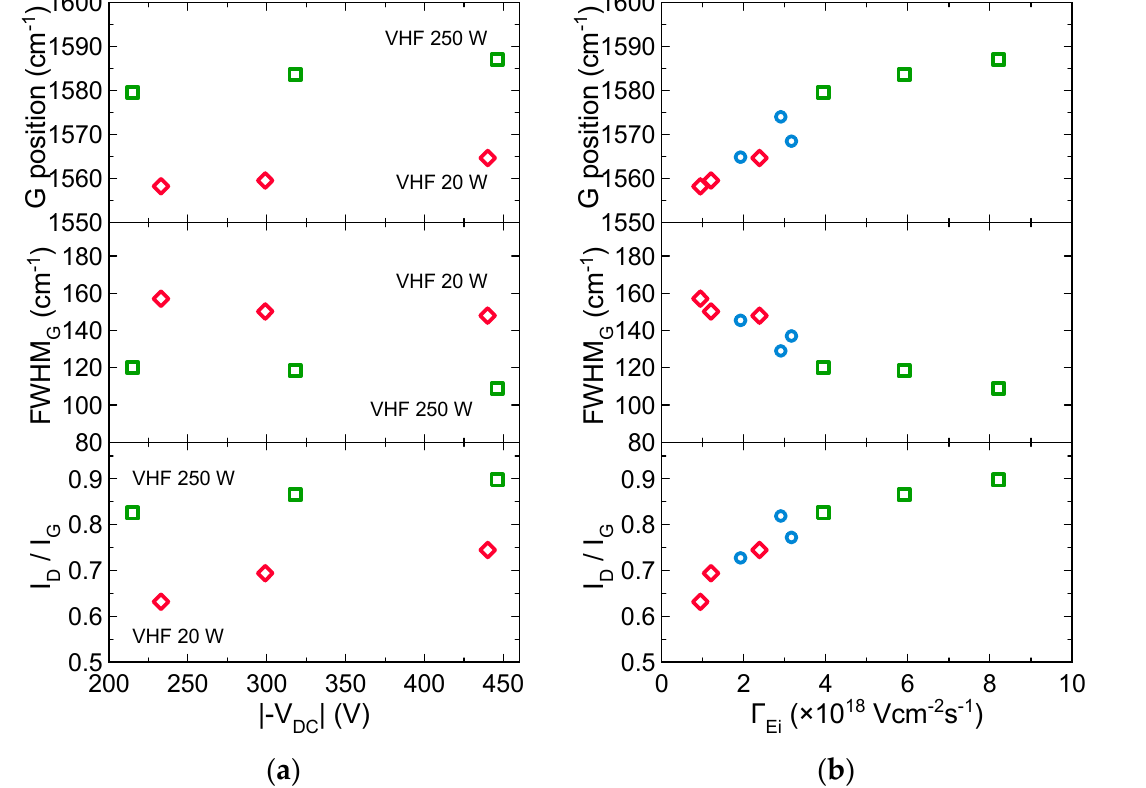
Figure 6. ( a ) The magnitude of the negative self-bias voltage |- V DC | and ( b ) the ion bombardment energy flux Γ E i dependences of G band position (G position), FWHM of G band (FWHM G ), and the intensity ratio of D band to G band (I D /I G ). Diamonds ( ◇ ) correspond to 20 W in VHF power, squares ( □ ) correspond to 250 W in VHF power, and circles ( ○ ) correspond to 50, 100, and 200 W in VHF power with 50 W of RF bias power. C 2019 , 5 FOR PEER REVIEW